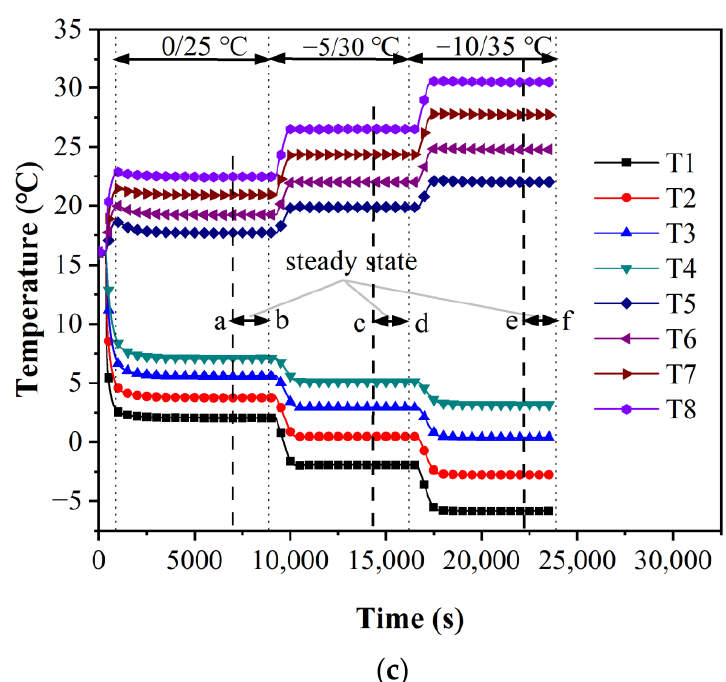
Figure 5. Experimental results of 304 stainless steel with the qualitative temperature of 12.5 ◦ C. ( a ) h = 10.22 mm, ( b ) h = 25.06 mm and ( c ) h = 40.02 mm.